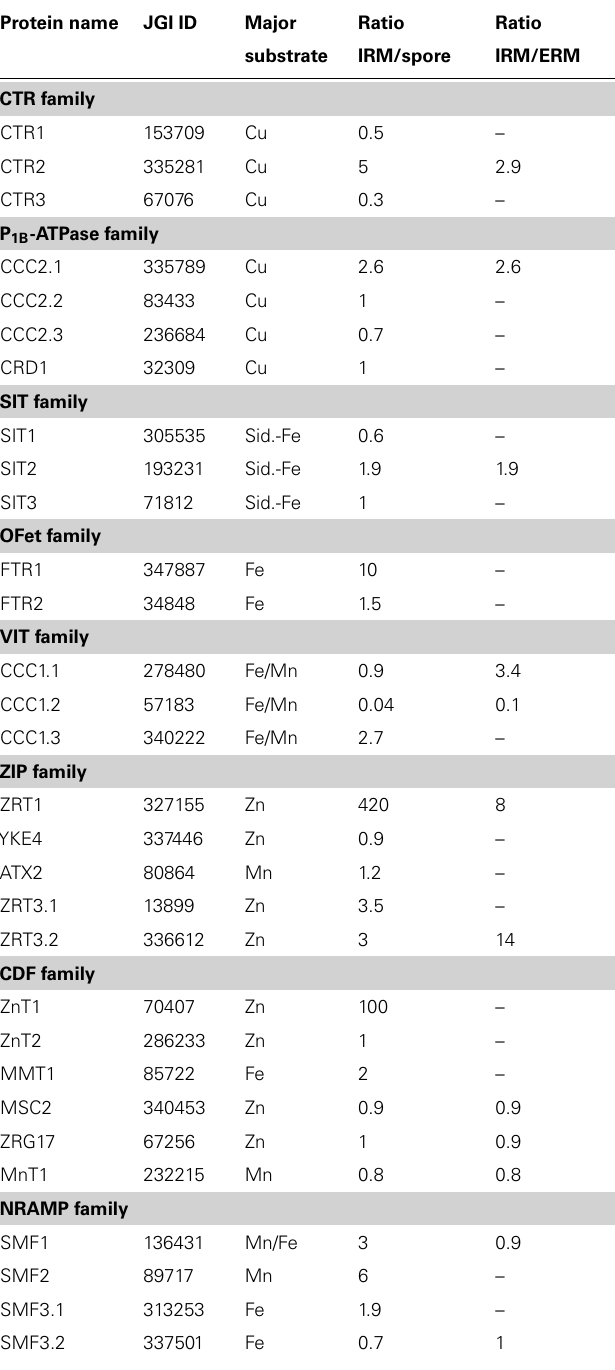
Table 1 | Overview of the putative metal transporters identified in the Rhizophagus irregularis genome. Protein name JGI